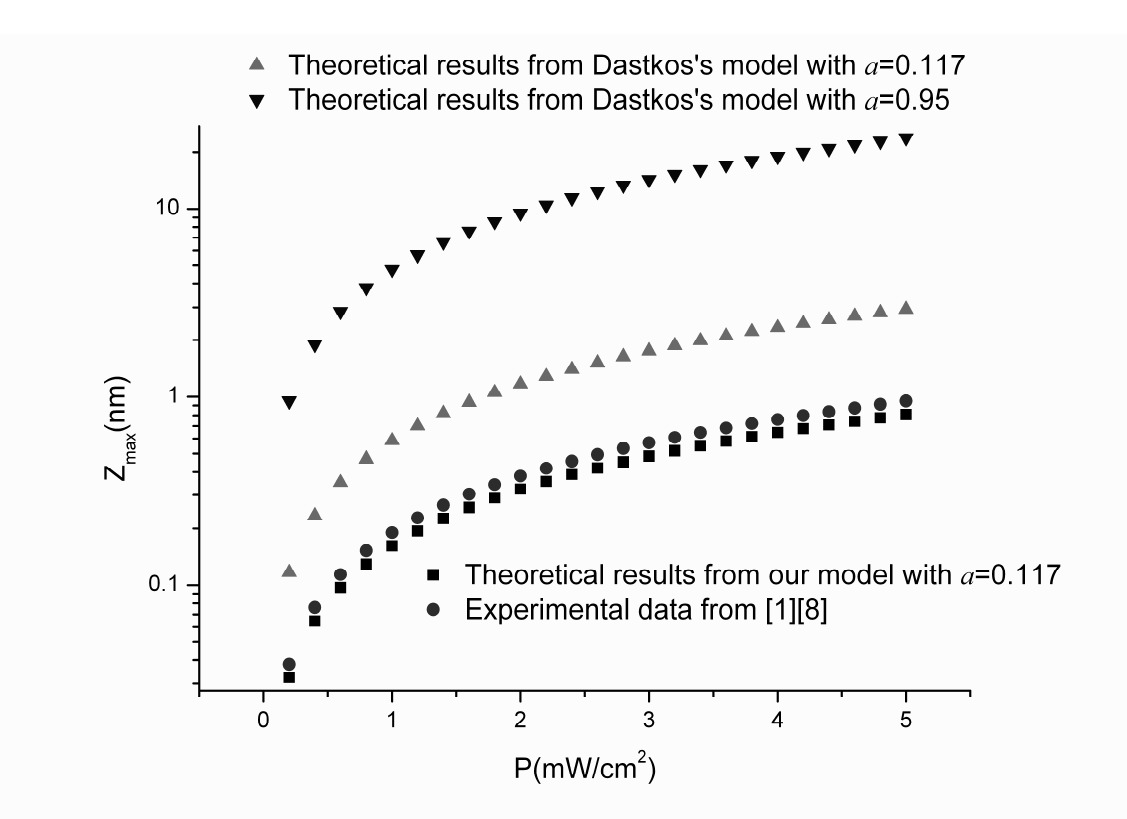
Figure 2 . Theoretical results from our model with a =0.117 and from Datskos’s model with a =0.95 and a =0.117, and the experimental data in [1,